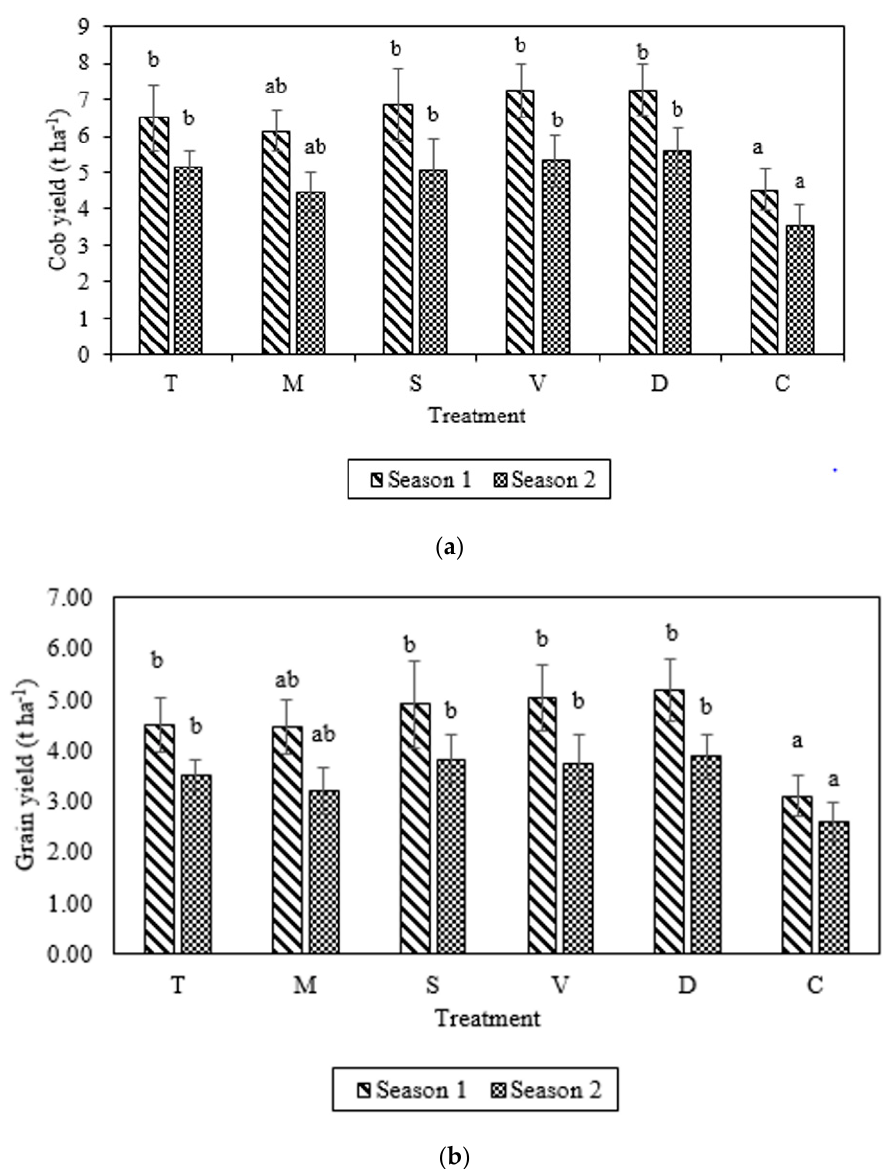
Figure 2. ( a ) Cob yield and ( b ) grain yield for different treatments for the two seasons. Different letters for the bar values across a season indicate significant differences ( p < 0.05), T: manure stored under the shade, M: manure stored in the open, S: slurry digestate, V: vermicompost, D: DAP, and C: no fertilizer.